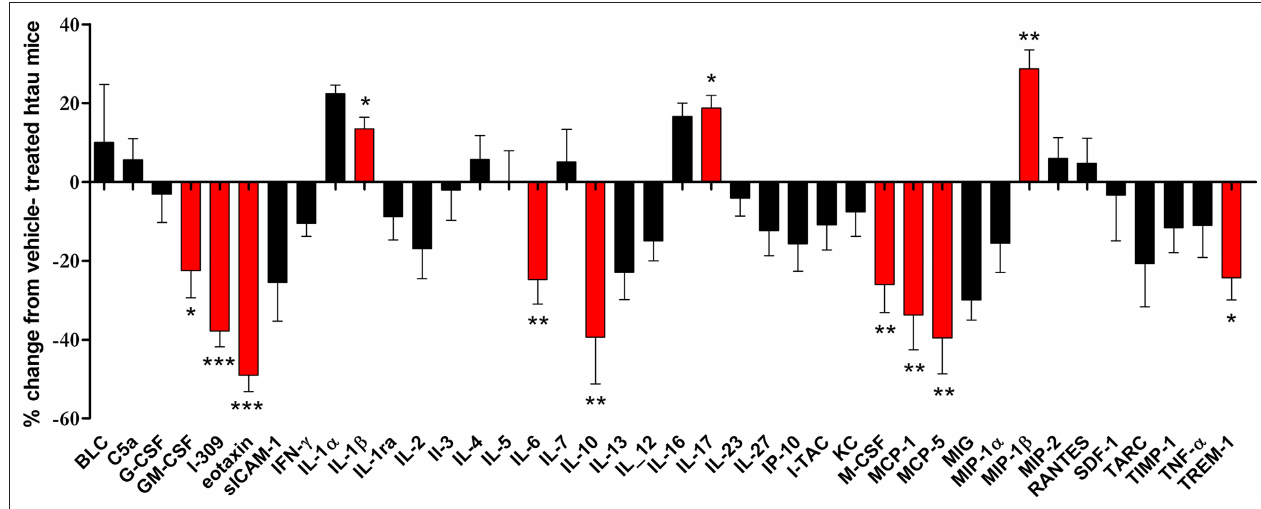
Figure 4 | The effect of minocycline treatment on protein amounts of inflammatory mediators in the cortex of 3- to 4-month-old htau mice. Bar chart shows the protein amounts of cytokines in the cortex of minocycline-treated as a percentage of those in vehicle-treated htau mice. Values represent mean ± SEM, * p < 0.05, ** p < 0.01, *** p < 0.001. n =